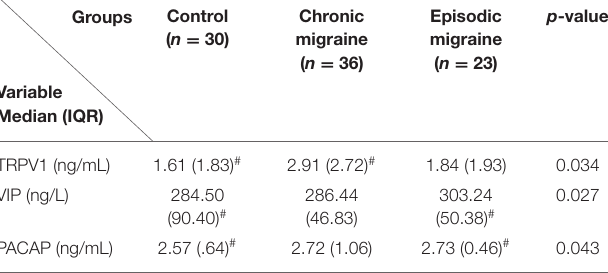
TABLE 3 | Comparison of serum levels of TRPV1 (ng/ml), VIP (ng/l), and PACAP (ng/ml) according to the studied groups [data are shown as median (interquartile